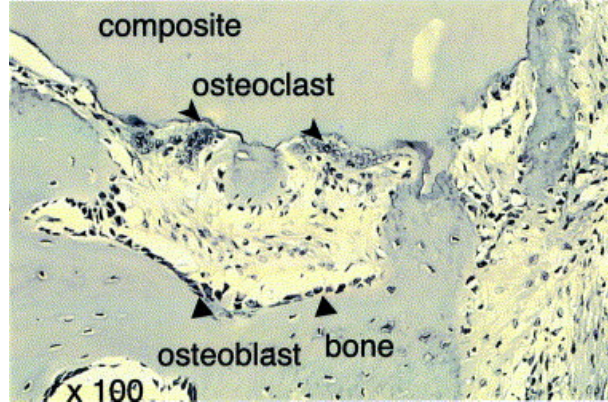
Figure 4. HE-stained histological section (×100) of HAp/Col composite implanted into a beagle’s tibia for 12 weeks. Triangles indicate elongated cells, and arrowheads multinucleated giant cells. Reprinted from [40] with permission from Elsevier.